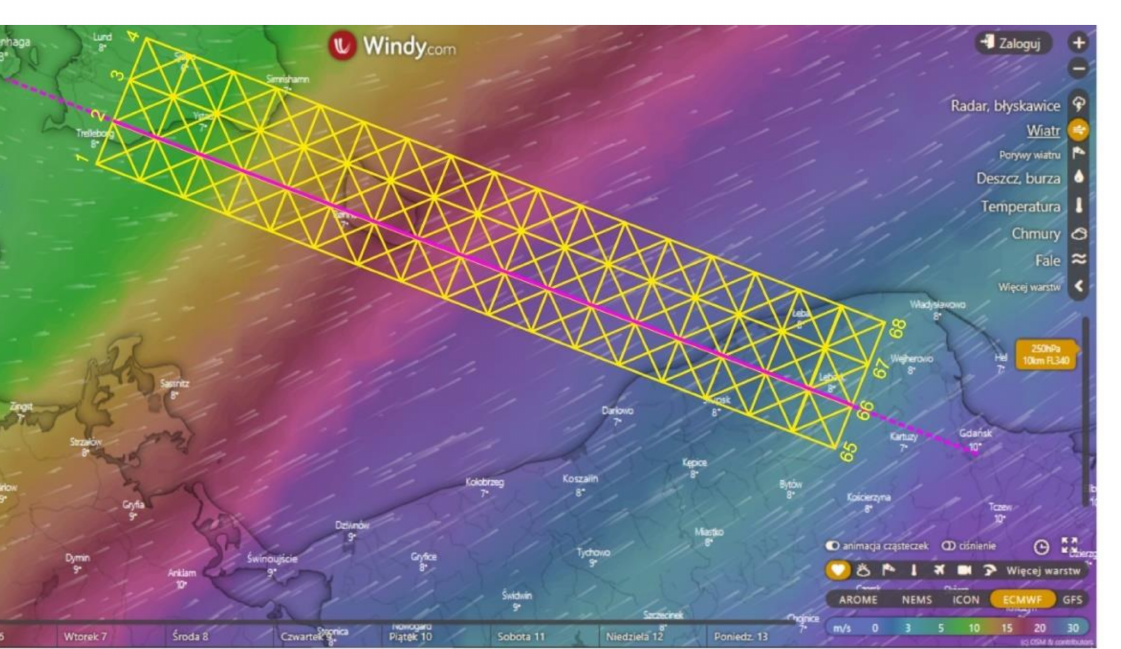
Figure 5. Visualization of wind directions and speeds at 10 km in the research airspace on 6 April 2020 ([30]), with a graph adopted to conduct the research; a reference trajectory (R) of the flight from Copenhagen to Gdansk is marked as a purple